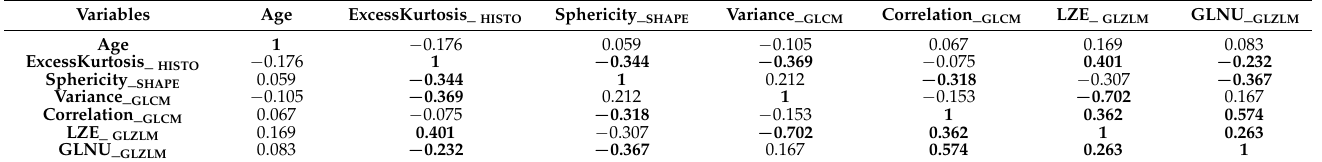
Table 3. Spearman correlations matrix for positron emission tomography variables of interest and age. Values in bold are those that correspond to statistically significant results.